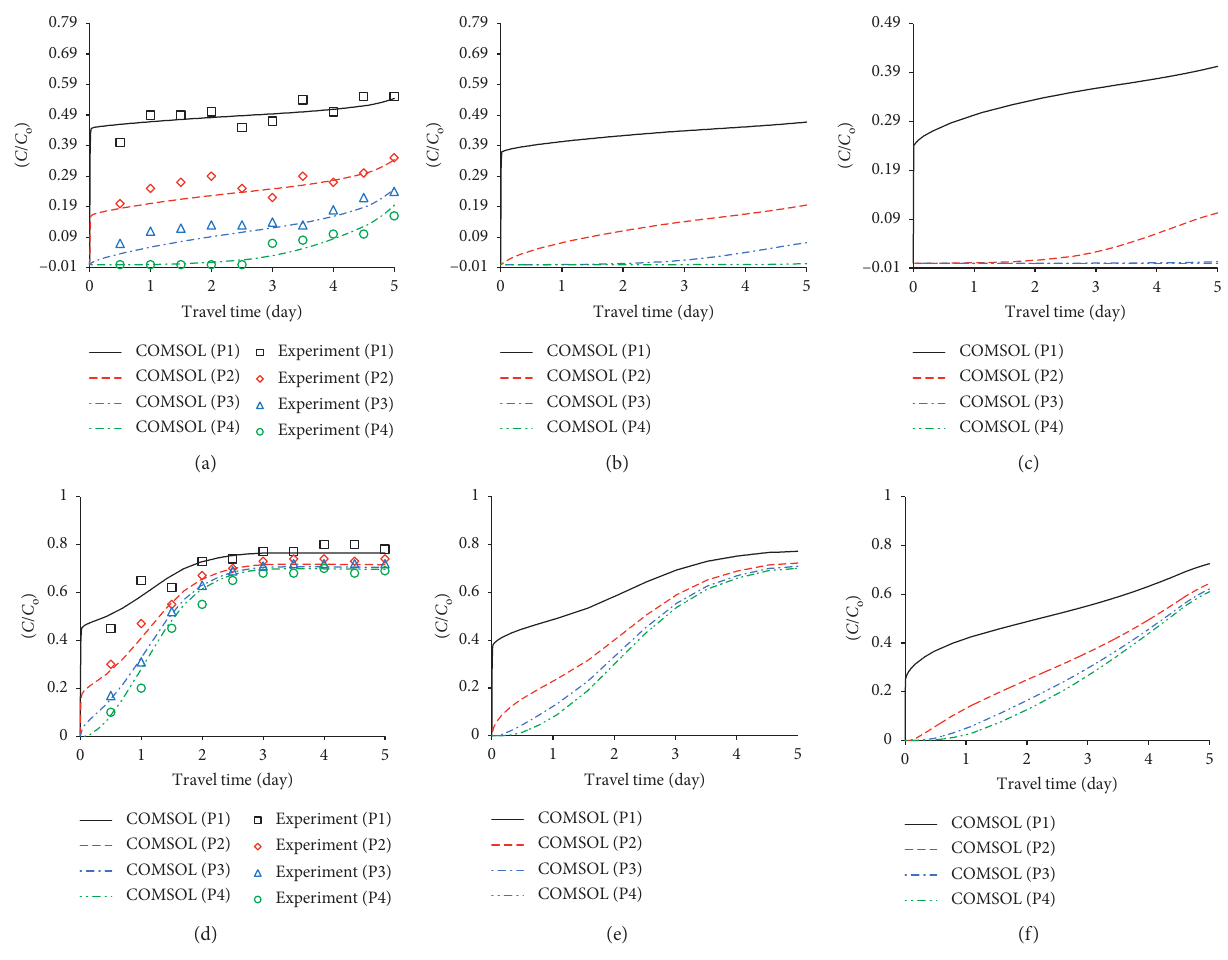
Figure 7: Measured and predicted breakthrough curves for Pb +2 and Ni +2 at selected locations in the sandy soil with presence of WFS-FS as PRB for flow rate of 100mL/min. (a) PRB (10cm, WFS+FS, lead (pH � 4)). (b) PRB (20 cm, WFS+FS, lead (pH � 4)). (c) PRB (30 cm, WFS+ FS, lead (pH � 4)). (d) PRB (10cm, WFS +FS, nickel (pH � 4)). (e) PRB (20cm, WFS +FS, nickel (pH � 4)). (f) PRB (30 cm, WFS+ FS, nickel (pH � 4)). Table 4: Longevities of WFS-FS barriers under the variation of thickness for capturing of Pb +2 and Ni +2 ions.